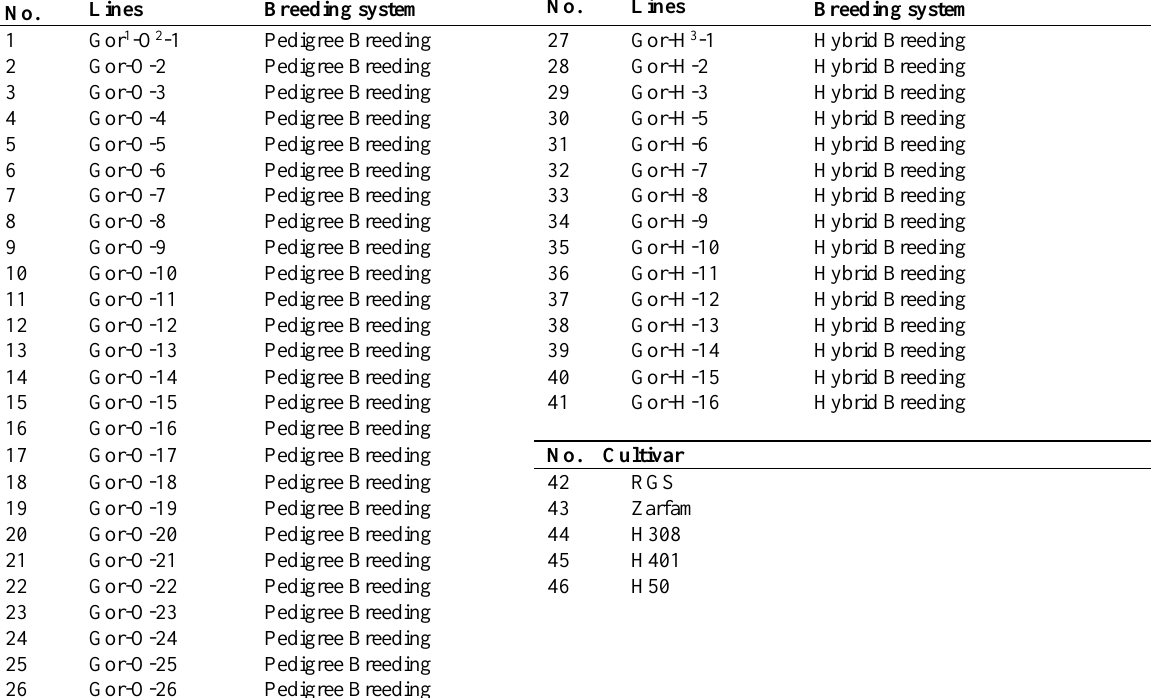
1=Gorgan; 2=Open pollinated Cultivar; 3=Hybrid Cultivar; GANRRTC = Golestan Agricultural and Natural Resources Research and Training Center Breeding company and distributor are